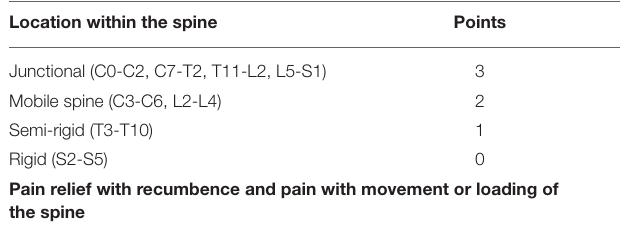
TABLE 4 | Spine Instability Neoplastic Scale (SINS).